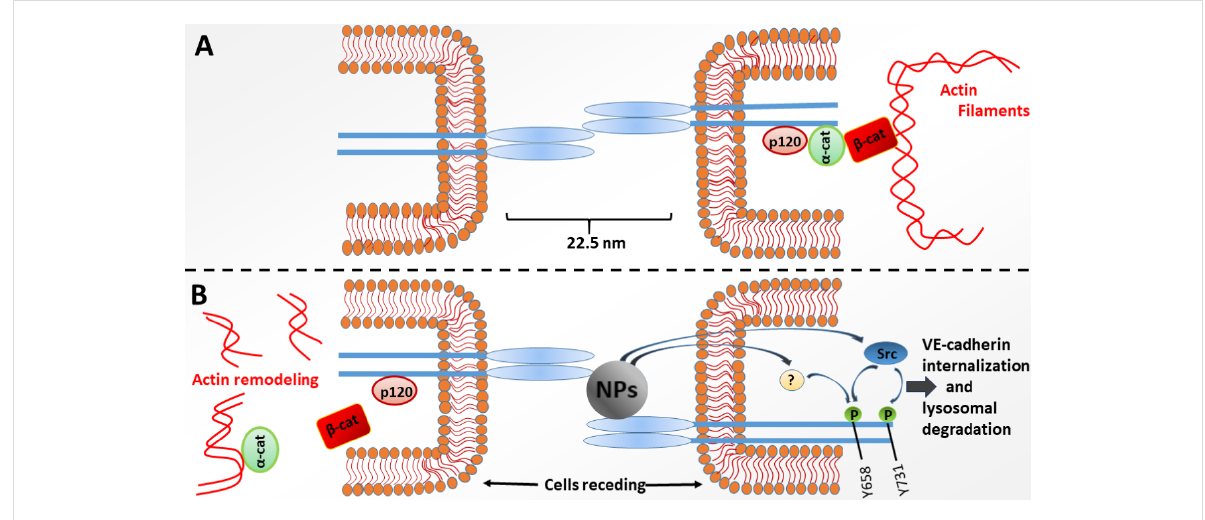
Figure 3: Mechanism of NanoEL. Adherens junctions between endothelial cells are maintained by a complex set of proteins, including the three-com- ponent complex of VE-cadherin, p120, and β -catenin. NPs disrupt homophilic VE-cad–VE-cad interactions between endothelial cells, triggering the phosphorylation of intracellular tyrosine residues Y658 (by an unknown kinase pathway) and Y731 (by Src kinase). This causes the loss of stability of the ternary complex of the adherens junctions and the recession of